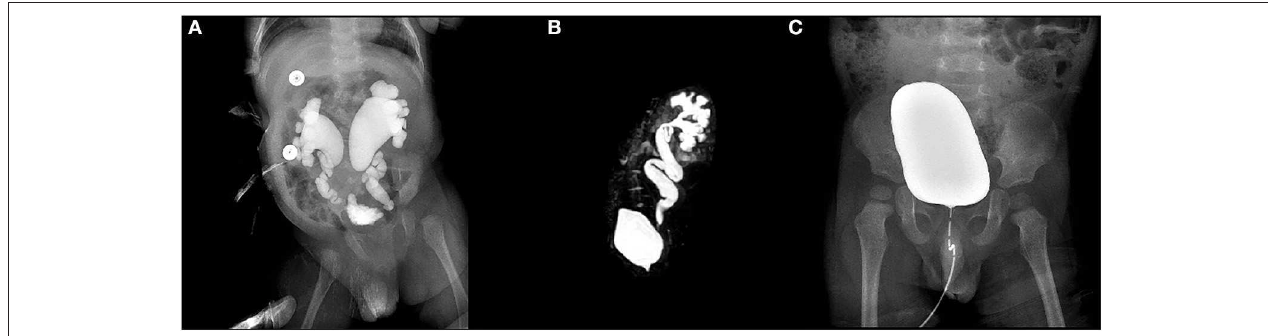
FIGURE 2 | Voiding cystourethrography (VCUG) demonstrated bilateral reflux in one patient with grade V vesicoureteral reflux (VUR) (A) . Magnetic resonance urography demonstrated hydroureteronephrosis in one patient with primary obstructive megaureter (POM) (B) . VCUG did not demonstrate reflux 3 months after stent removal (C) .